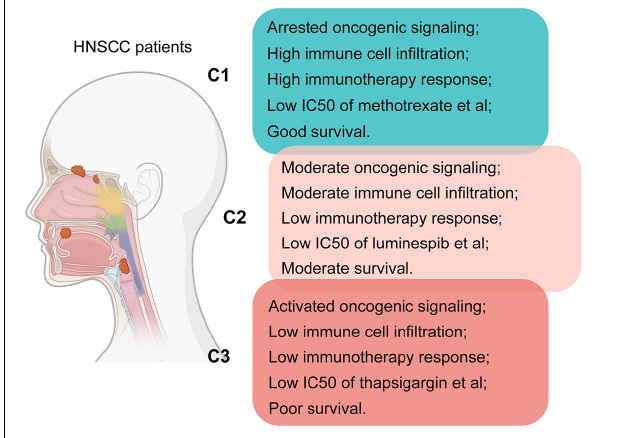
FIGURE 8 | Summary of features for patients of the three subtypes in this